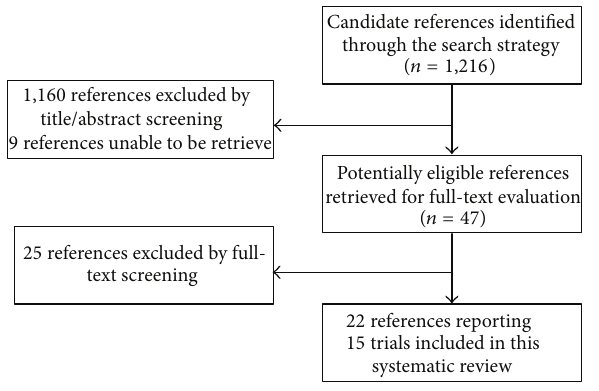
Figure 1: Summary of selection